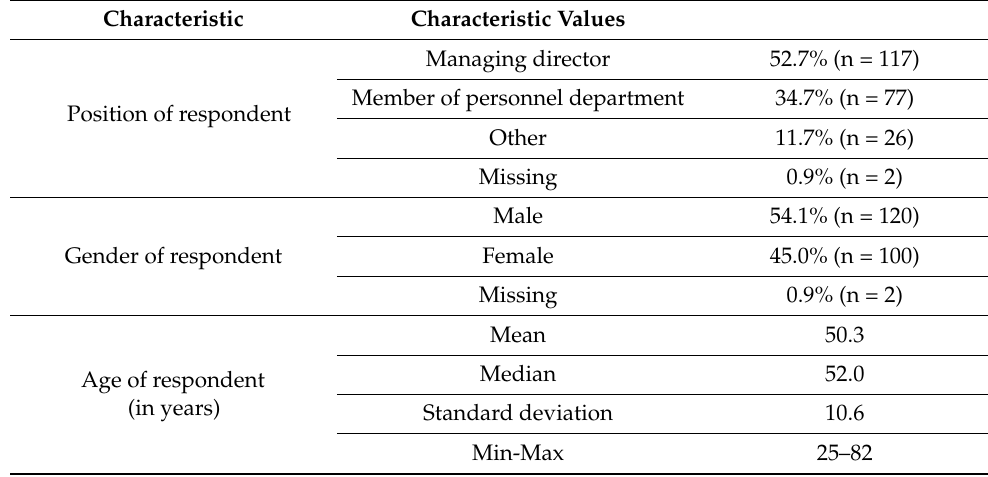
Table 2. Sociodemographic characteristics of respondents (source: [4]).